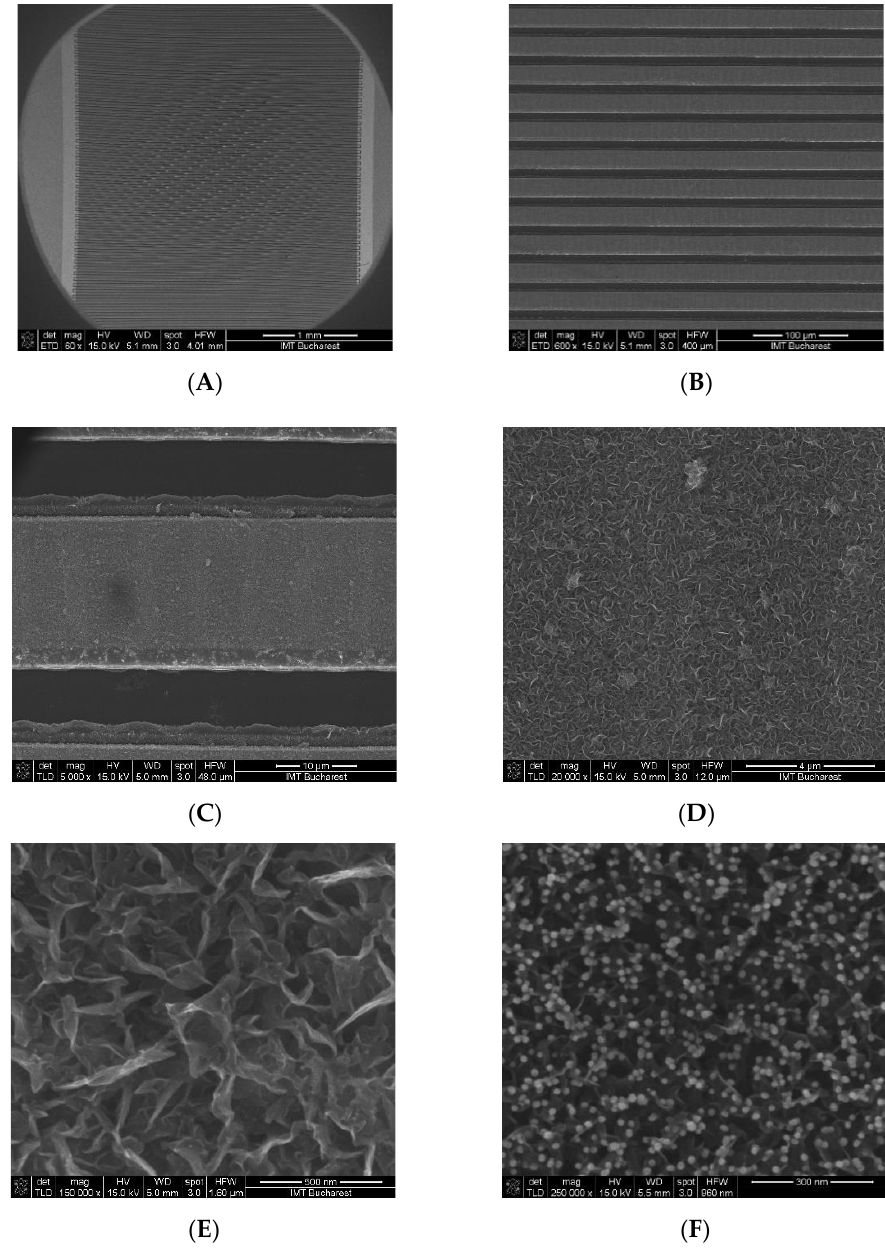
Figure 4. SEM micrographs of the vertical graphene working with interdigitated electrodes: ( A ) 60× magnification showing an overview image of the interdigitated electrodes; ( B ) 600× magnification showing a detailed image of the interdigitated working electrodes; ( C ) 5000× magnification showing a detailed image of a single electrode; ( D ) 20000× magnification showing vertical graphene grown on the electrodes; ( E ) 150000× magnification showing a detail of vertical graphene; ( F ) 250000× magnification showing a detail of vertical graphene functionalized with gold nanoparticles.